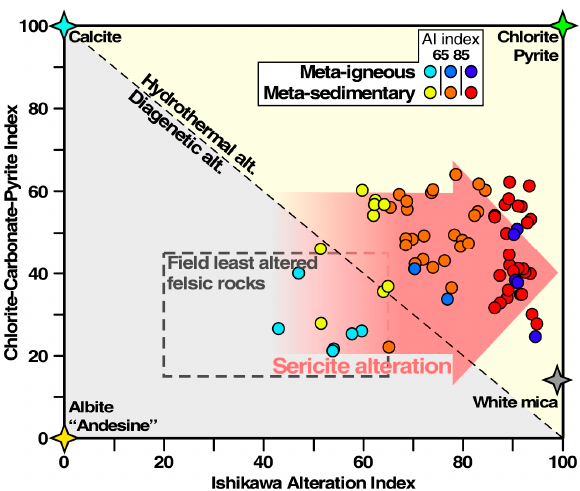
Figure 9. Alteration box plot for metasedimentary (“Filladi Inferiori” Fm) and metaigneous (Fornovolasco Metarhyolites Fm) samples. The red arrow represents the typical effect of sericite alteration. Fields for diagenetic (lower left) and hydrothermal (upper right) alteration are also reported (see [57] for further details).